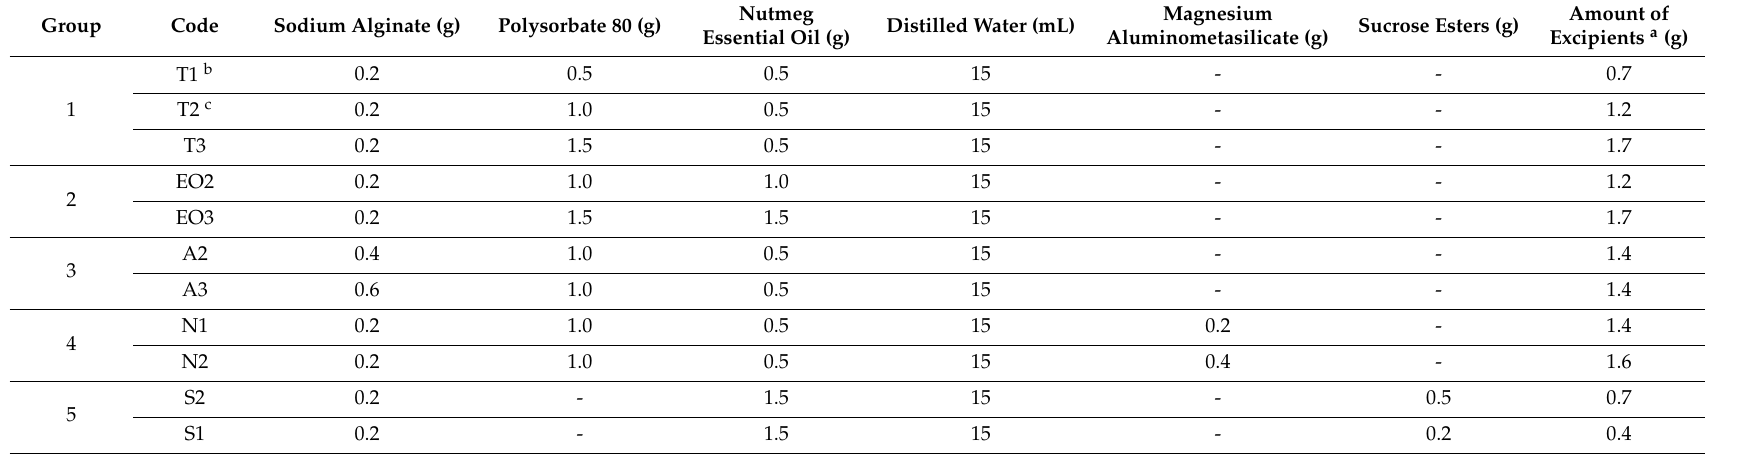
Table 1. The composition of emulsions from which the nutmeg essential oil (NEO)-loaded microcapsules were